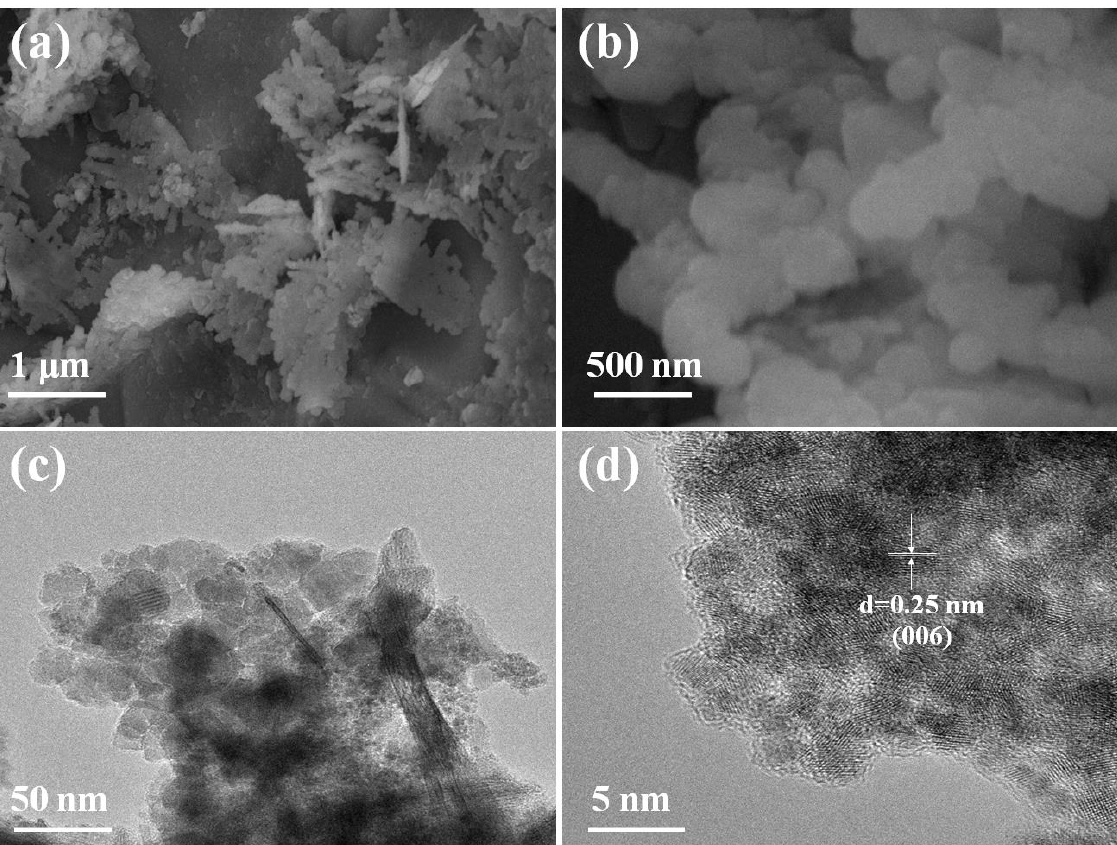
Figure 2. ( a ) SEM images of the MnO 2 sample; ( b ) an SEM image of the cobalt-doped@MnO